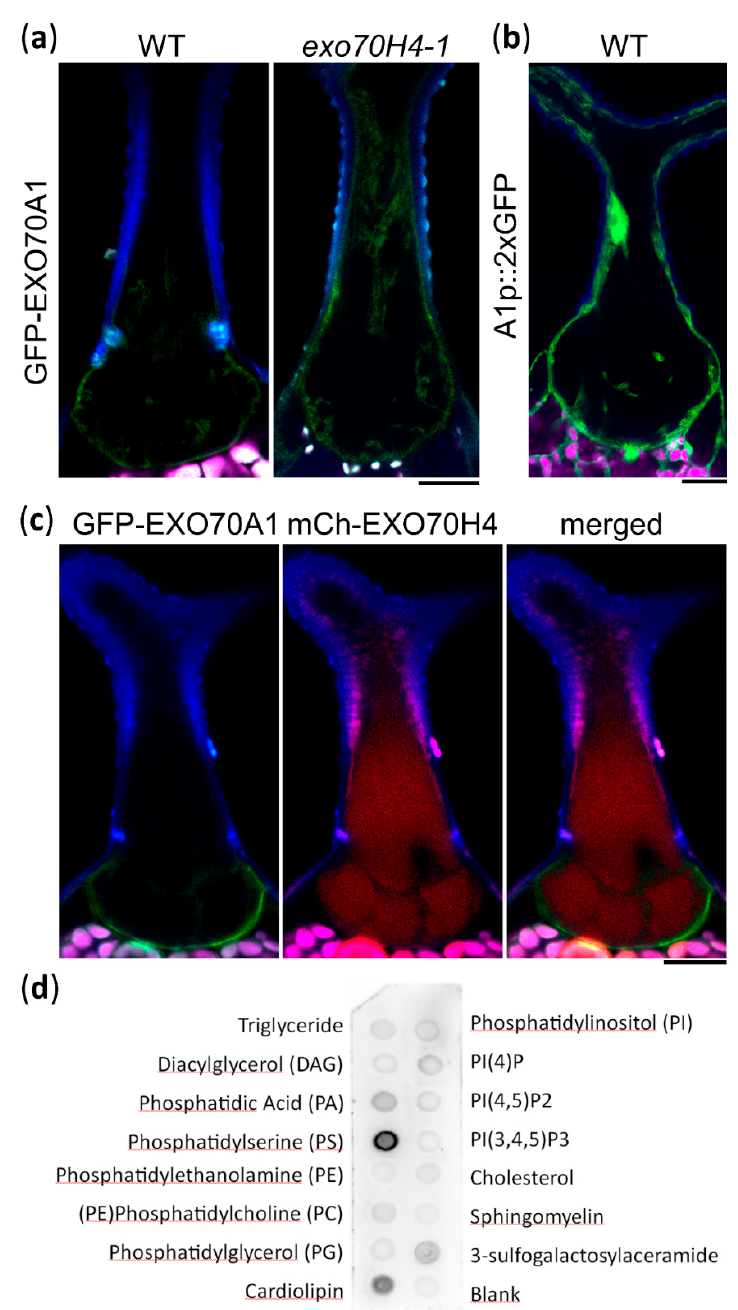
Figure 3. Trichome plasma membrane domains recruit different EXO70 proteins. ( a )